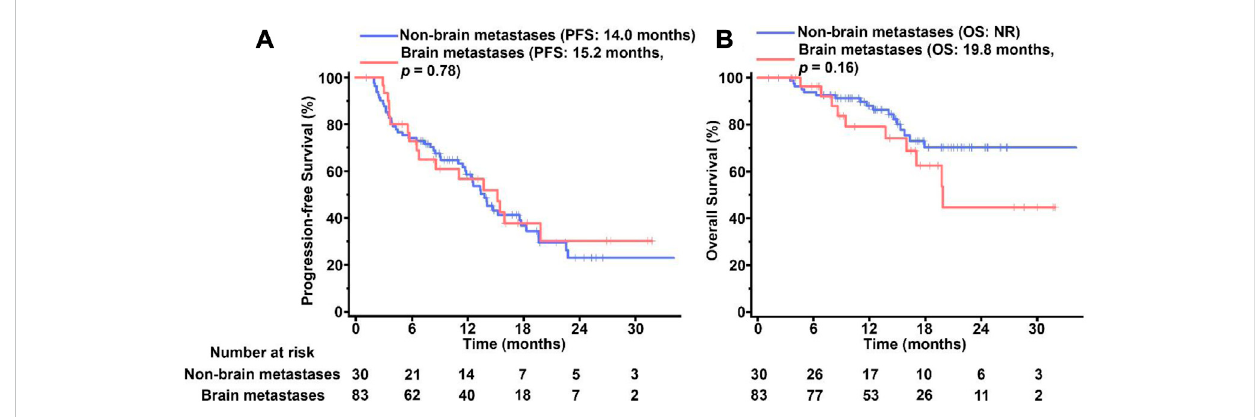
FIGURE 3 Kaplan-Meier survival of curves PFS (A) and OS (B) in pyrotinib-treated MBC patients with and without BM. The tick marks indicate thetime points at which the data were censored. NR, not reached.